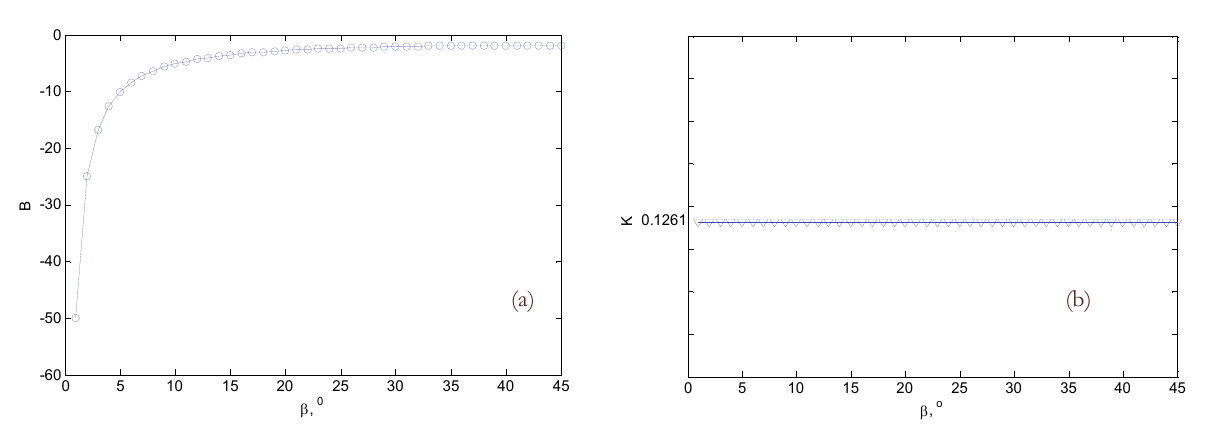
Figure 1: Dependence of the parameter B on (a) the angle  and (b) K value for 10HNAP steel.